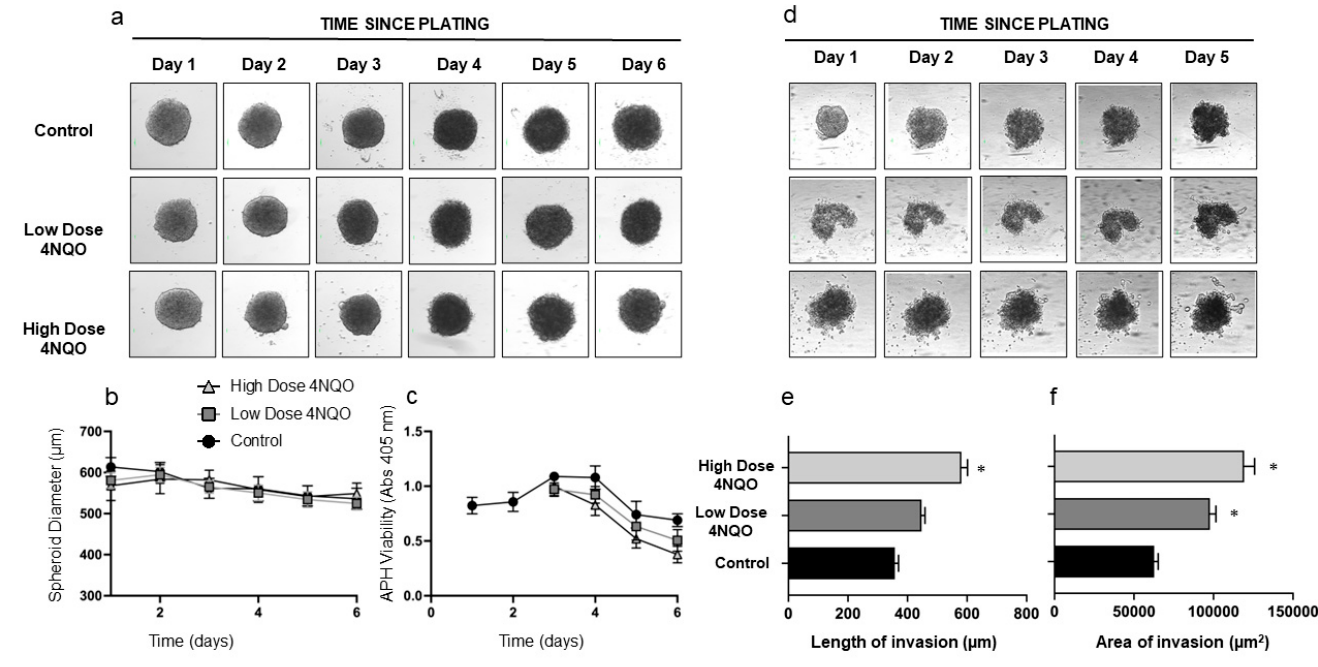
Figure 2. Size, viability, and invasiveness of DOK spheroids treated with the carcinogen 4NQO. ( a ) Representative images of DOK spheroids on days 1–6, treated daily for 90 min with low (0.36 µM) or high (0.72 µM) doses of 4NQO. Cells were plated in low-adherence plates at 10,000 cells per well, and media was changed daily. ( b ) Diameter of control and 4NQO-treated spheroids measured in µm. ( c ) Viability of control and 4NQO-treated spheroids assessed using APH assay (absorbance read at 405 nm). ( d ) Representative images of a Matrigel invasion assay using control and 4NQO-treated spheroids on days 0–4. ( e ) Invasiveness of 4NQO-treated spheroids as measured by length of invasion (µm). ( f ) Invasiveness of 4NQO-treated spheroids as measured by area of invasion in µm 2 . All error bars are mean ± SEM, and significance is assessed as * p < 0.05.